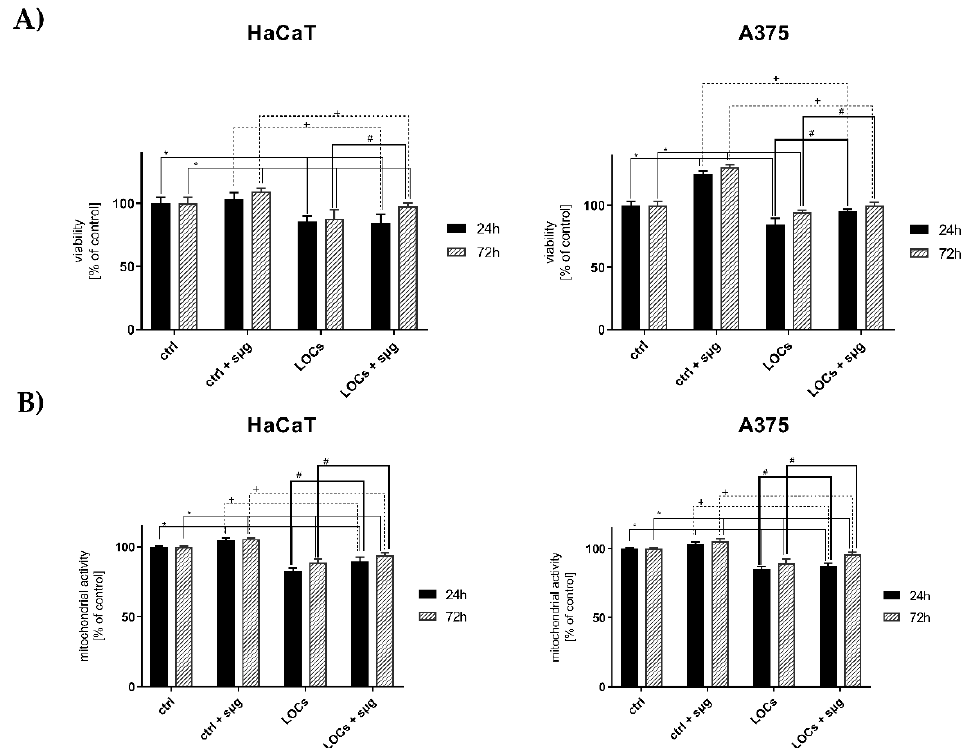
Figure 2. Evaluation of HaCaT and A375 cells viability ( A ) and mitochondrial activity ( B ) after the exposure to simulated microgravity. Statistically significant differences in comparison to ctrl cells: *, ctrl + sµg cells: +, and LOC cells: # ( p ≤ 0.05).